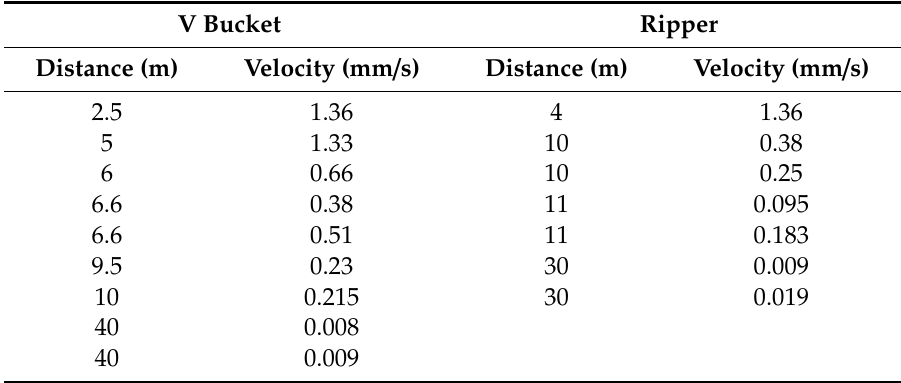
Table 2. Velocities at di ff erent distances for the excavation